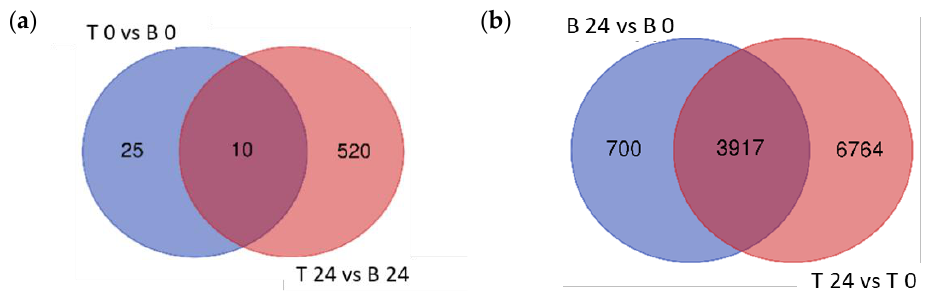
Figure 4. Venn diagrams of the differentially expressed genes. Differentially expressed genes (DEGs) of the different contrast groups (( a ) B 24 vs. B 0 and T 24 vs. T 0) and (( b ) T 0 vs. B 0 and T 24 vs. B 24) were enumerated to illustrate the specific DEGs for each comparison and their overlap.